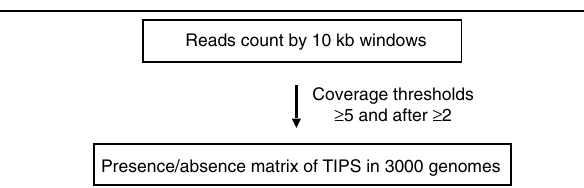
Fig. 1 TRACKPOSON method. Schematic representation of the